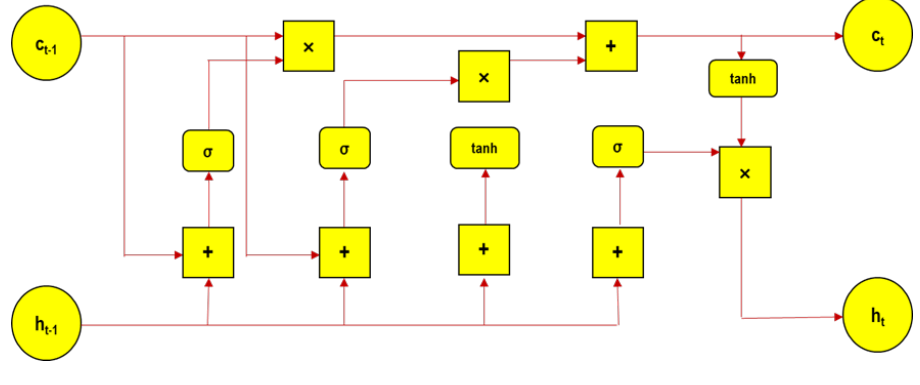
Figure 4. LSTM architecture.